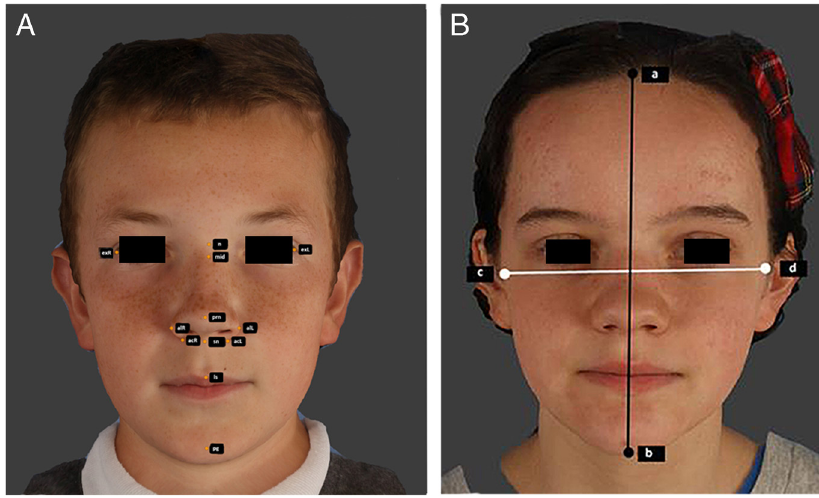
Figure 1. (A) Facial landmarks and (B) facial ratio showing face height measured from hairline to soft tissue chin, and face width measured from left to right